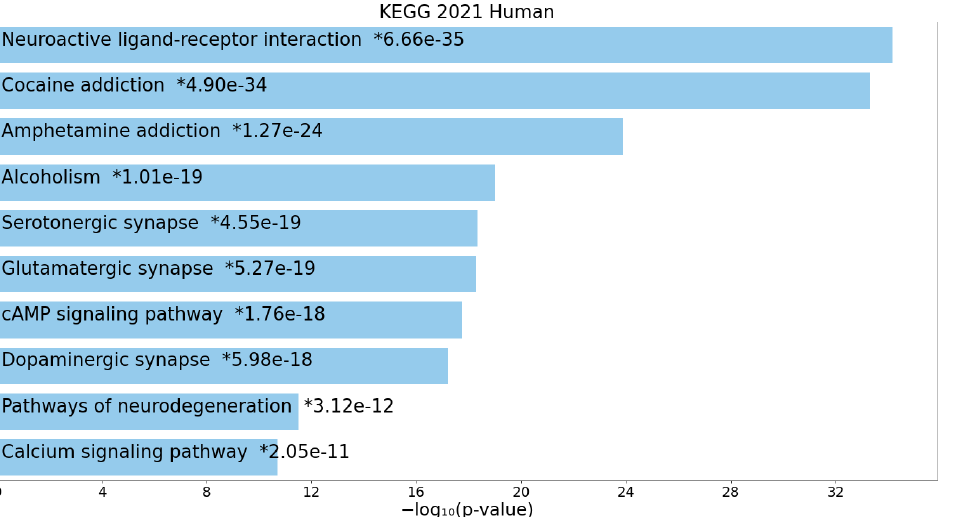
Figure 2. Bar chart of top enriched terms from the KEGG_2021_Human gene set library. The top 10 enriched terms for the input gene set are displayed based on the -log10 ( p -value), with the actual p -value shown next to each term (*). The term at the top has the most significant overlap with the input query gene set.